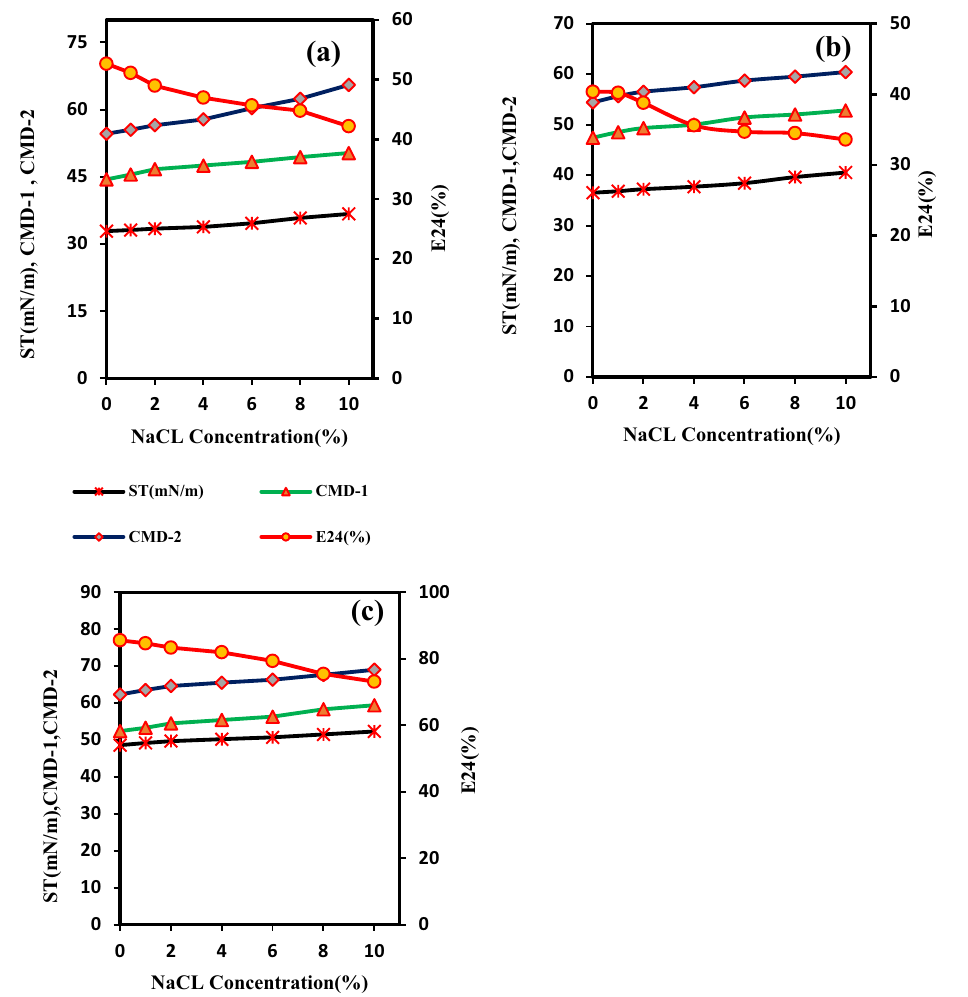
Figure 1. Evaluation of salinity stability (0–10%) in three different surfactants produced by ( a ) SH21, ( b ) SHA302 and, ( c ) SH72. ST surface tension, E24 emulsification test, CMD −1 and CMD −2 critical Micelle dilution of broth diluted 10 and 100 times,